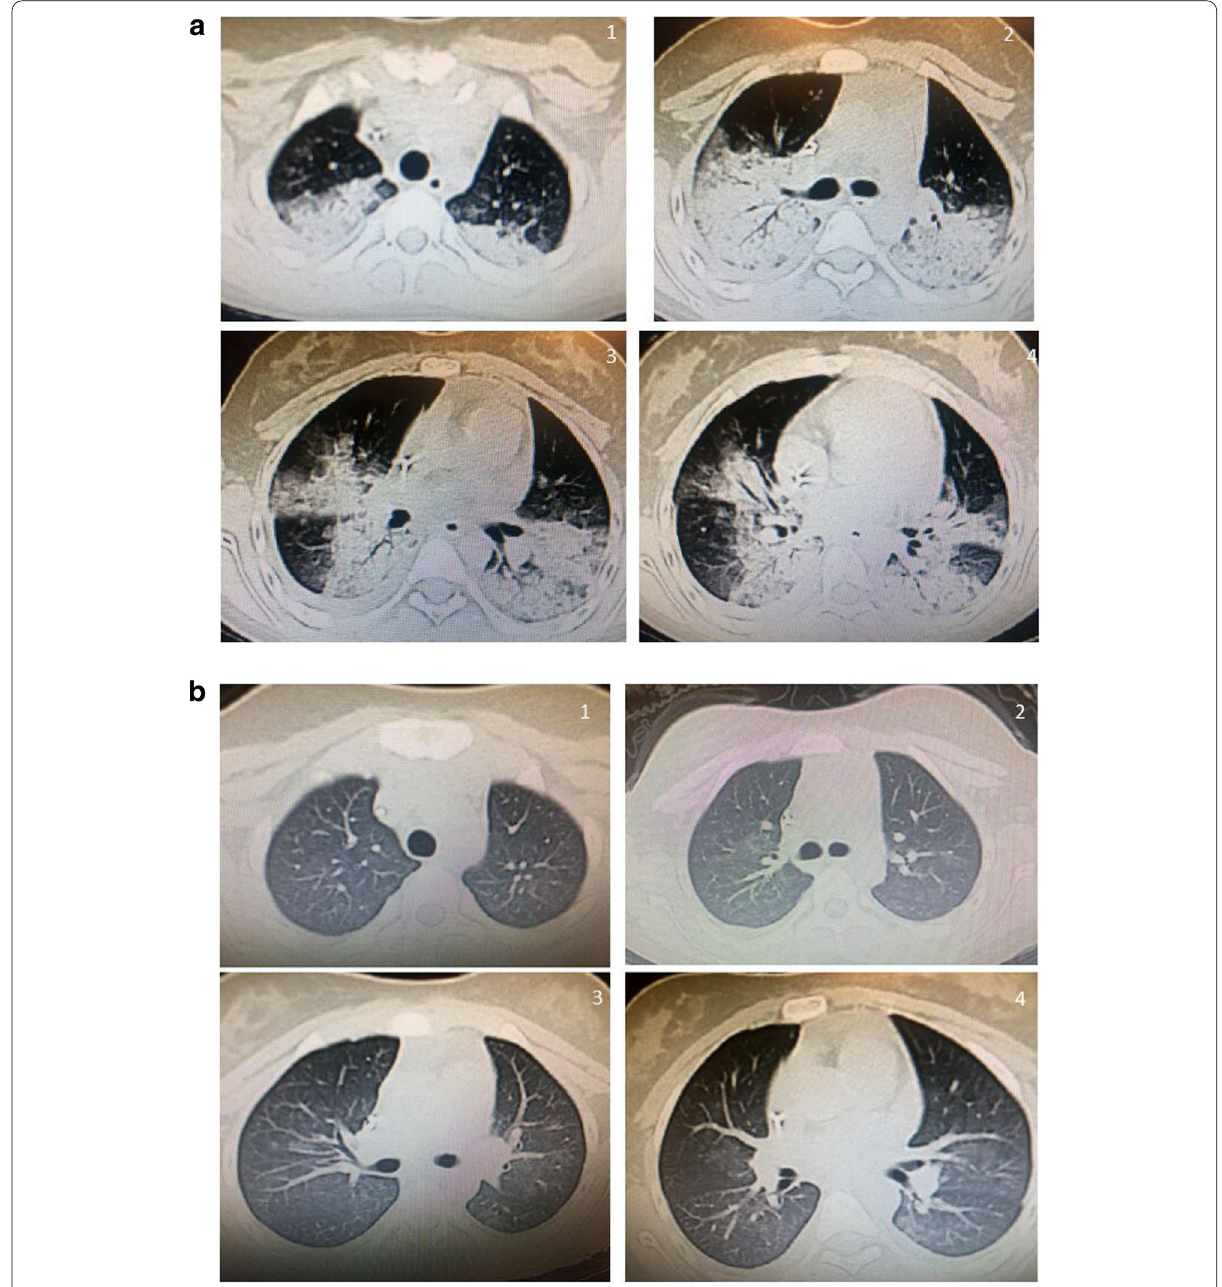
Fig. 1 a Case 1 initial serial CT cuts showing the large bilateral pulmonary predominantly posterior diffuse areas of ground-glass opacities and consolidations with related accentuated vascularity and septal thickening (CO-RADS 5). b Follow-up case 1 serial CT cuts showing significant regressive course with near total resolution but still seen bilateral diffuse mosaic attenuation of ground glass